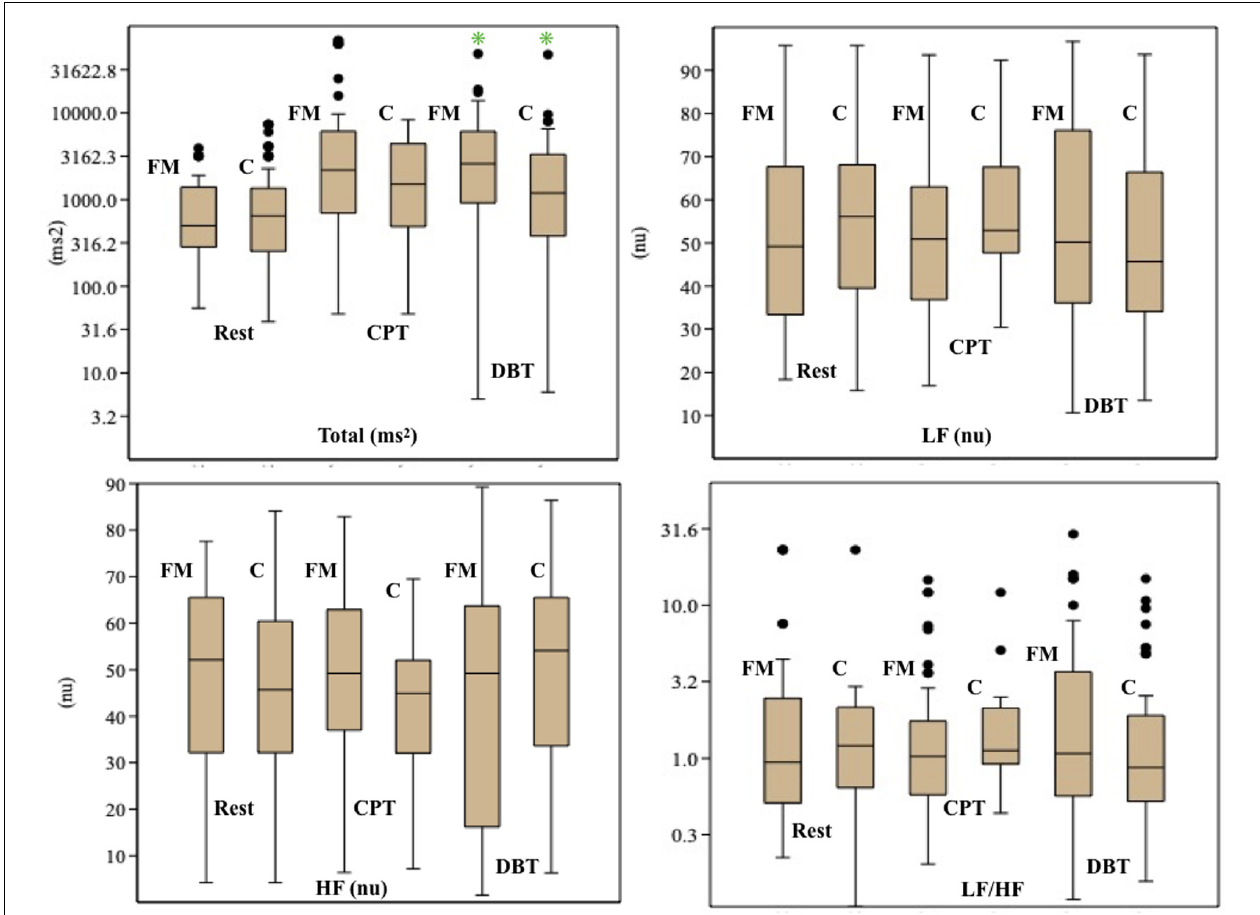
FIGURE 4 | Box-and-whisker plot for comparison of frequency domain parameters of heart rate variability among fibromyalgia and control groups during rest, CPT, and DBT. Data are expressed as median with interquartile range. Statistics: Mann–Whitney U -test. C, control group; CPT, cold pressor test; DBT, deep breathing test; FM, fibromyalgia group; HF, high frequency; LF, low frequency; n.u., normalized unit; Total, total power. * p <